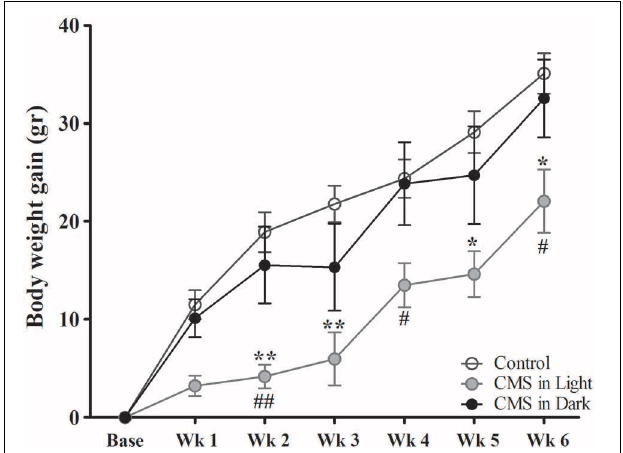
FIGURE 2 | Body weight gain during the CMS protocol. Controls, n = 20, each CMS group, n = 14; ∗ , # P < 0 . 05. ∗∗ , ## P < 0 . 01. Data presented as mean ± s.e.m. ∗ indicates a significant difference between the CMS-Light and the CON group and # show a significant difference between the CMS-Light and CMS-Dark. There were no significant differences between the CMS-Dark and the CON group.